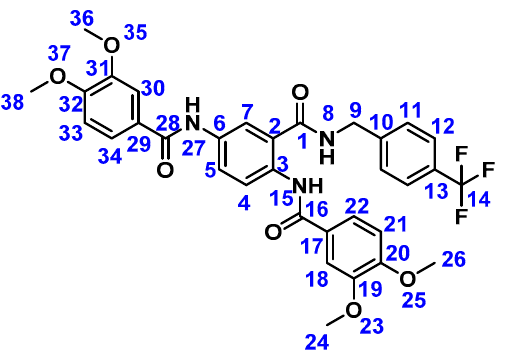
Figure 8. Structure of compound 1b and atom numbering used for NMR characterization